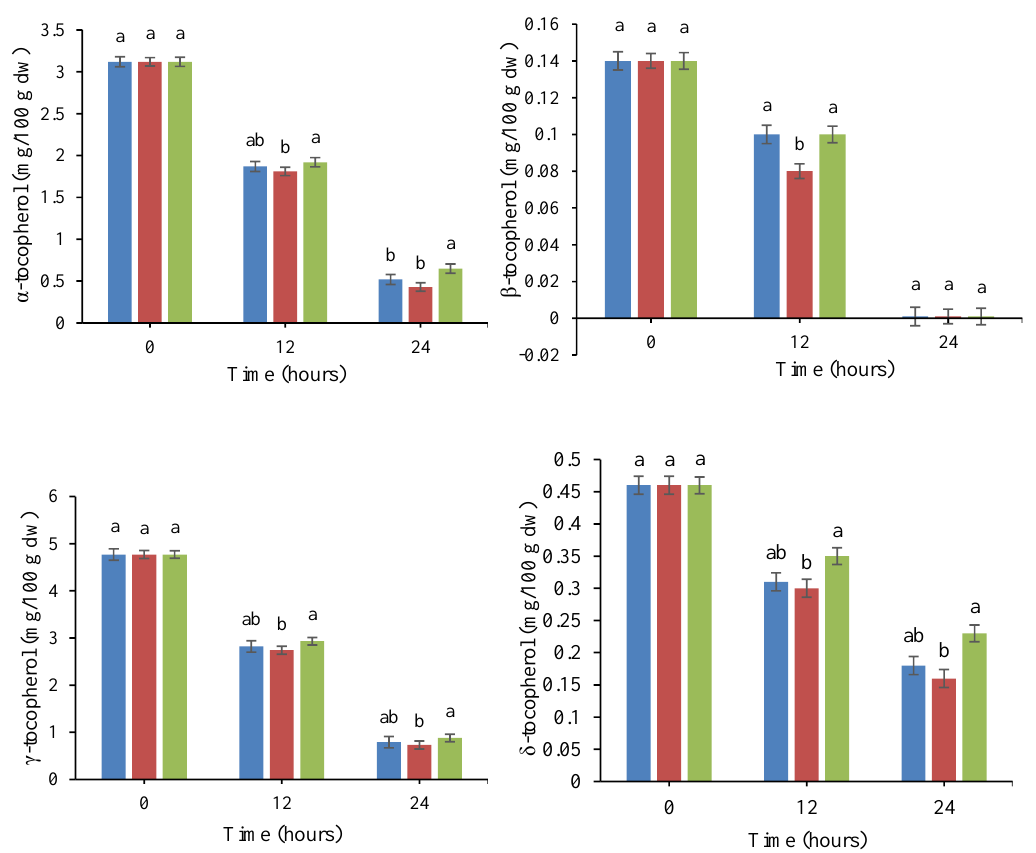
Figure 3. Changes in the levels of tocopherol isomers in quinoa seed fermented by pure and binary mixed cultures of two Lactobacillus species. The error bars reveal the standard deviation of each measurement in quinoa seed over 24 h of fermentation. The values with the same lowercase letters are not significantly different within the same fermentation hour ( p > 0.05). Red column: Lacticaseibacillus rhamnosus monoculture; blue column: Limosilactobacillus fermentum monoculture; green column: binary co-cultures of L. rhamnosus and L. fermentum.